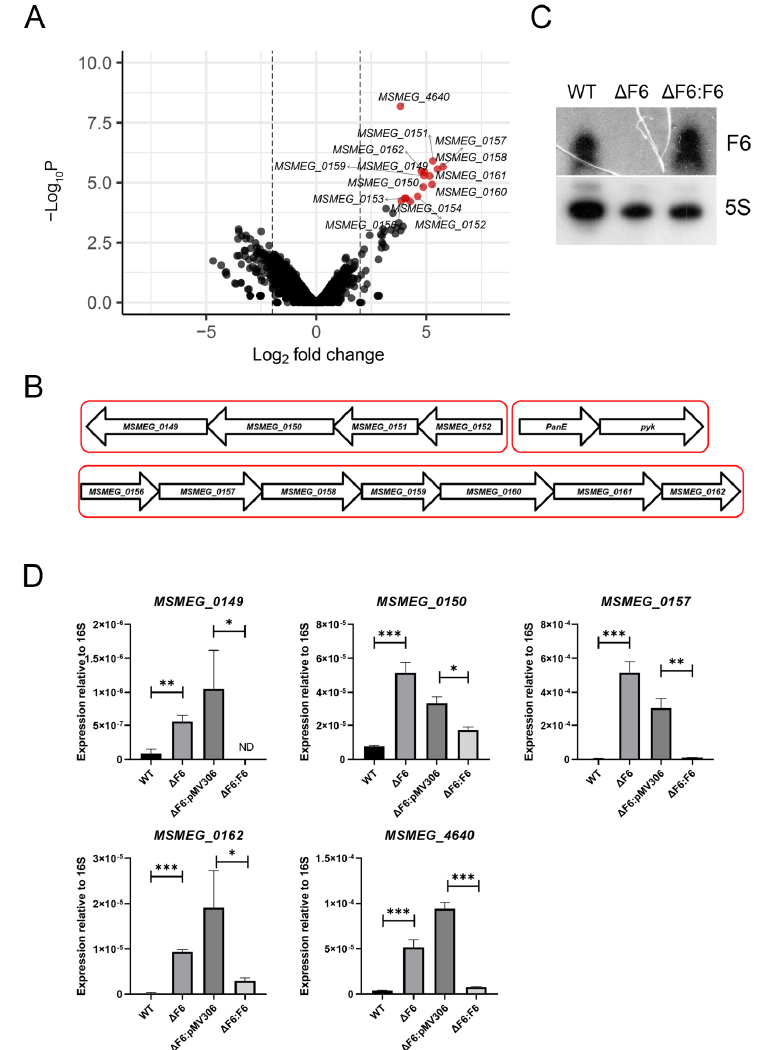
Figure 2. RNA-seq of the wt and Δ F6 strains. ( A ) Volcano plot of differentially expressed genes (DEGs) constructed using Enhanced Volcano R package [24]. Fold changes of gene expression were plotted. Significant DEGs were identified by > four-fold change (log2 FC > 2) and <0.05 FDR, and are shown in red. ( B ) Schematic representation of the gene clusters upregulated in the ∆ F6 strain. ( C ) Northern blotting analysis of F6 transcription in the wt, ∆ F6, and F6 complemented ( ∆ F6:F6) strains. ( D ) Validation of DEGs by qRT-PCR. mRNA expression was determined in the wt, ∆ F6, ∆ F6:pMV306, and ∆ F6:F6 cultures in the mid-log phase and normalized to that of 16S rRNA. * p < 0.05, ** p < 0.01, and *** p < 0.001. The data are presented as the mean and SD of three biological replicates for each